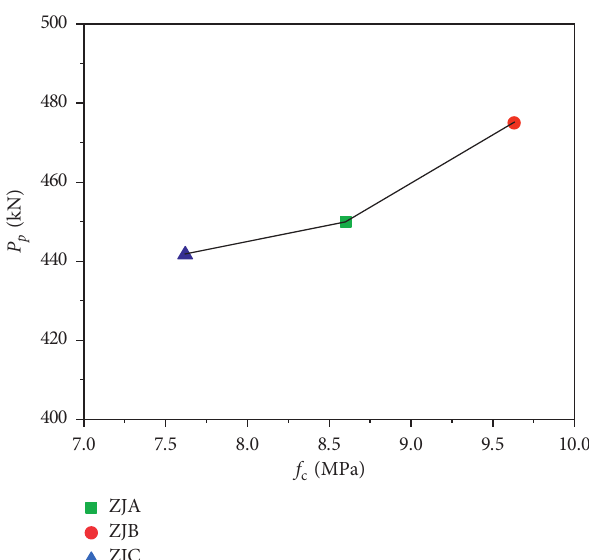
Figure 11: Concrete strength and peak load curves.